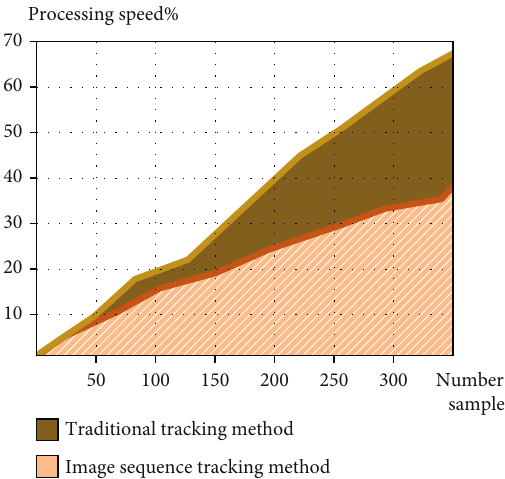
Figure 8: Comparison of processing speed between traditional method and image sequence tracking method.